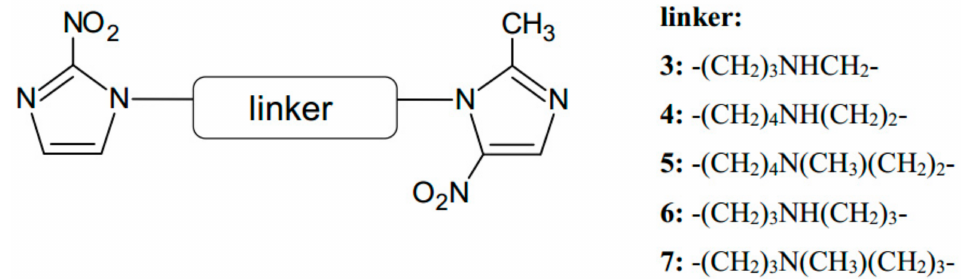
Figure 3. The structures of the most active aminoalkyl-linked analogs ( 3 – 7 ).